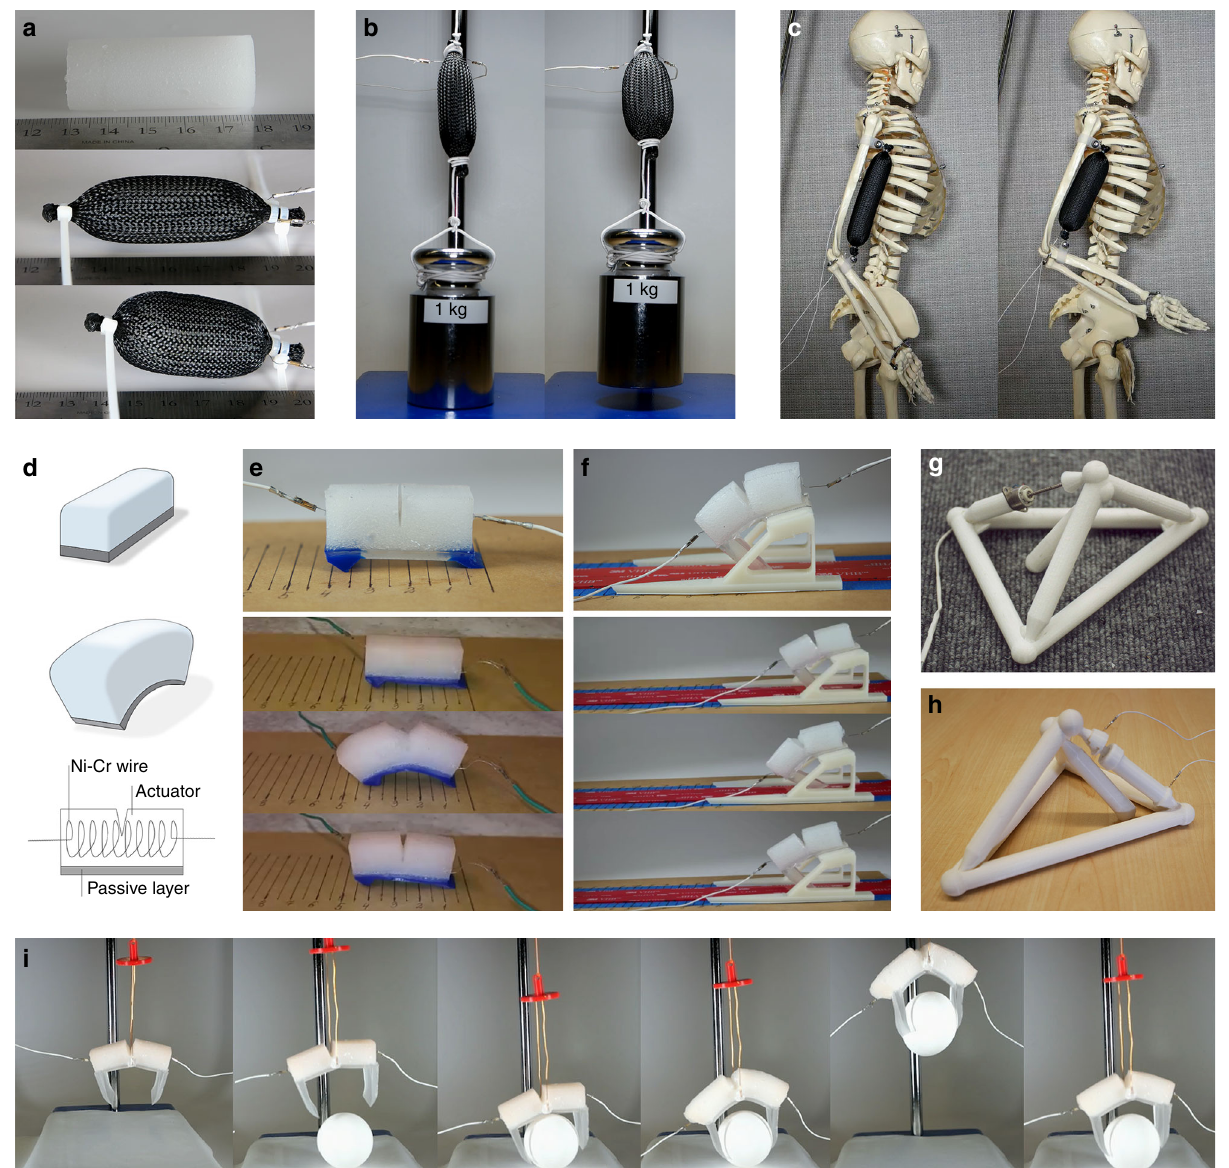
Fig. 4 Implementation of the soft composite material as an actuator. a McKibben-type arti fi cial muscle (soft composite material inside braided mesh sleeving) shows displacement of about 25%. b 13 g arti fi cial muscle lifts the weight of 1 kg. c Soft arti fi cial muscle implemented as a biceps lifting skeleton ’ s arm to 90° position at elbow ( a – c : actuation powered at 45 W (30 V, 1.5 A)). d Design of the bi-morph bending actuator. e All-soft two-leg “ worm ” and its locomotion powered at 8 W (8 V, 1 A). f The sleigh robot and its locomotion powered at 8 W (8 V, 1 A). g Tetrahedral robot evolved and 3D-printed in 2000 34 with embedded electrical motor. h The same robot with the soft composite material as an actuator embedded instead of the electrical motor. i Soft gripper lifting an egg (sequence from left to right; 8 V, 1